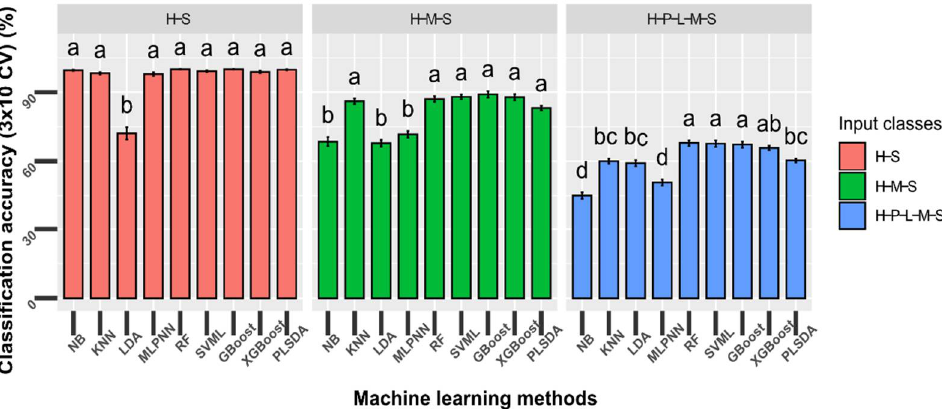
Figure 3. Comparison of the performance of nine machine learning methods to classify mock-inoculated healthy peanut plants and plants inoculated with Athelia rolfsii at different stages of disease development. Peanut plants from the greenhouse study were categorized based on visual symptomology: H = ‘Healthy’, mock-inoculated control with no symptoms; P = ‘Presymptomatic’, inoculated with no symptoms; L = ‘Lesion only’, inoculated with necrotic lesions on stems only; M = ‘Mild’, inoculated with mild foliar wilting symptoms ( ≤ 50% leaves symptomatic); S = ‘Severe’, inoculated with severe foliar wilting symptoms (>50% leaves symptomatic). Machine learning methods tested: NB = Gaussian Naïve Bayes; KNN = K-nearest neighbors; LDA = linear discriminant analysis; MLPNN = multi-layer perceptron neural network; RF = random forests; SVML = Support vector machine with linear kernel; GBoost = gradient boosting; XGBoost = extreme gradient boosting; PLSDA = partial least square discriminant analysis. Bars with different letters were statistically different using nonparametric Friedman and Nemenyi tests with an α level of 0.05. Error bars indicate standard deviation of accuracy using stratified 10-fold cross-validation (CV) repeated three times.